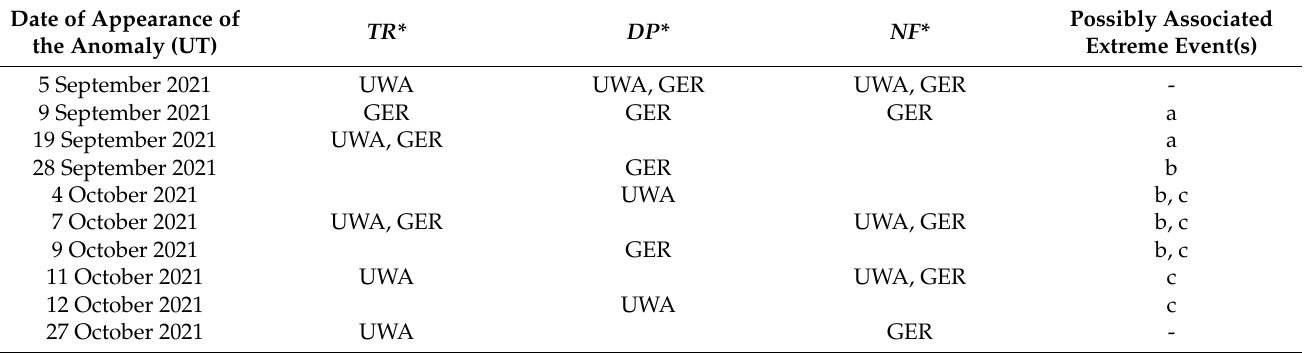
Table 3. Results of NFM for the 2021 Crete EQs. UWA and GER denote the station where the corresponding anomaly in TR * , DP * , or NF * has been